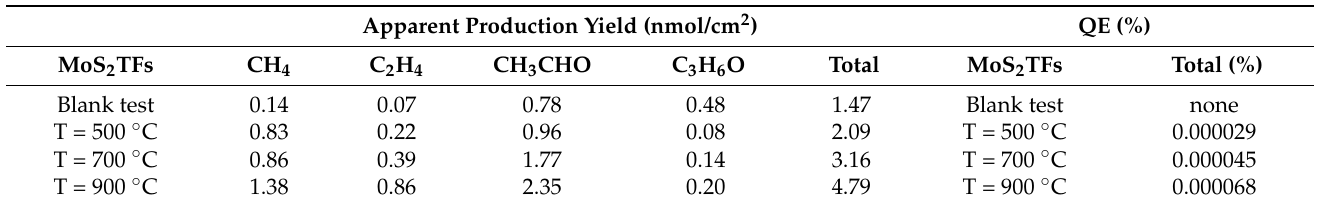
Table 2. Production yields and QEs of MoS 2 TFs synthesized at various reaction temperatures.